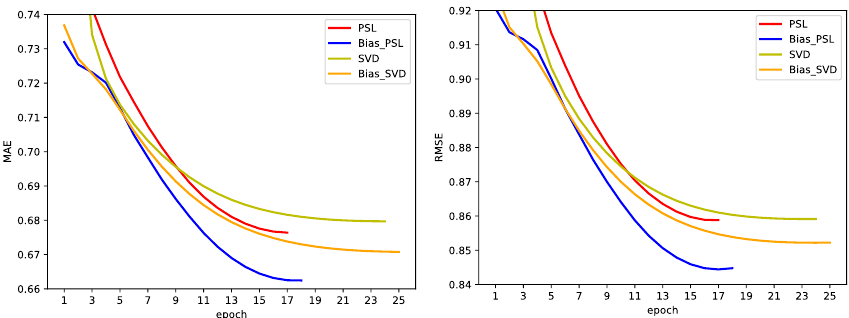
Figure 5. Training process of compared models on MovieLen-1 M with 100 latent factors.